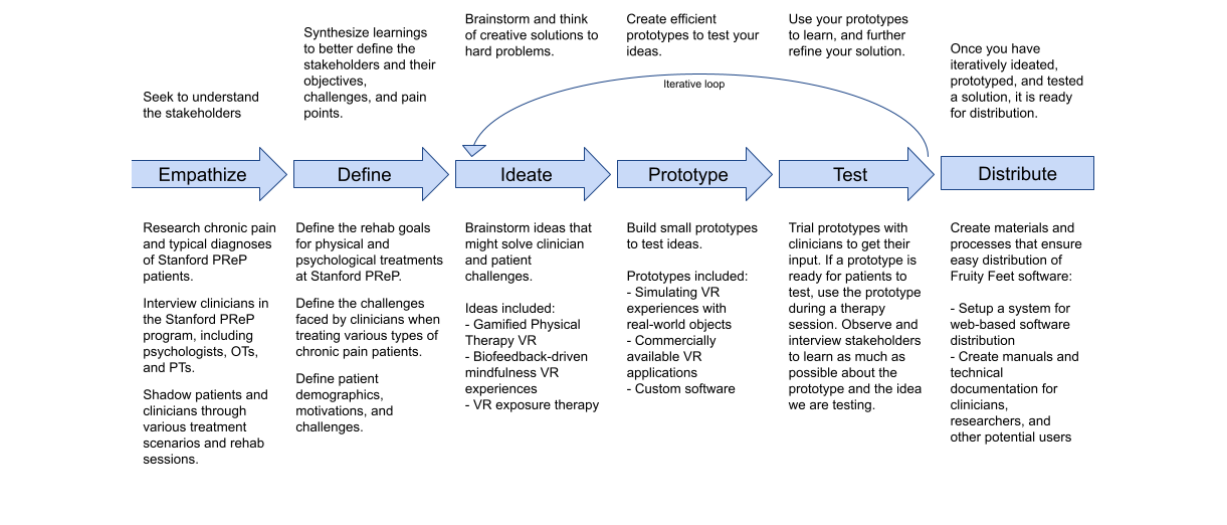
Figure 1. Fruity Feet/Design Thinking Development. PTs: physical therapists; OTs: occupational therapists; VR: virtual